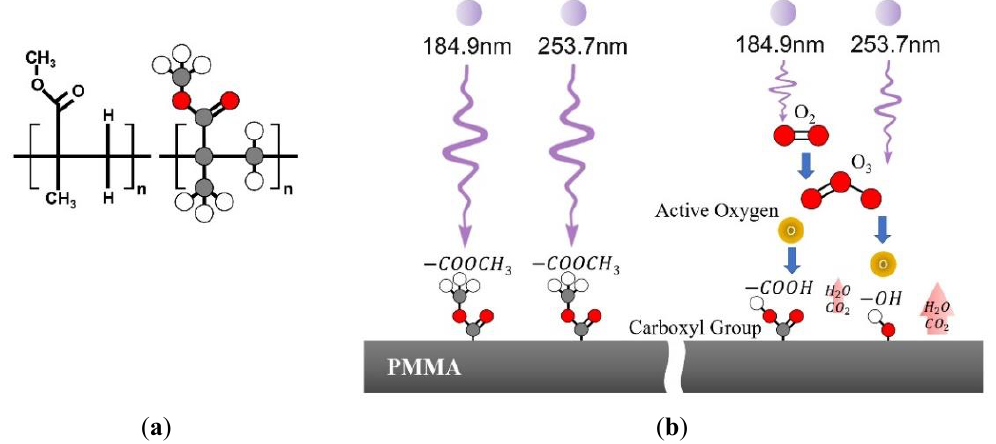
Figure 1. ( a ) Chemical structure of Polymethylmethacrylate (PMMA), ( b ) mechanism of PMMA surface modification by UV